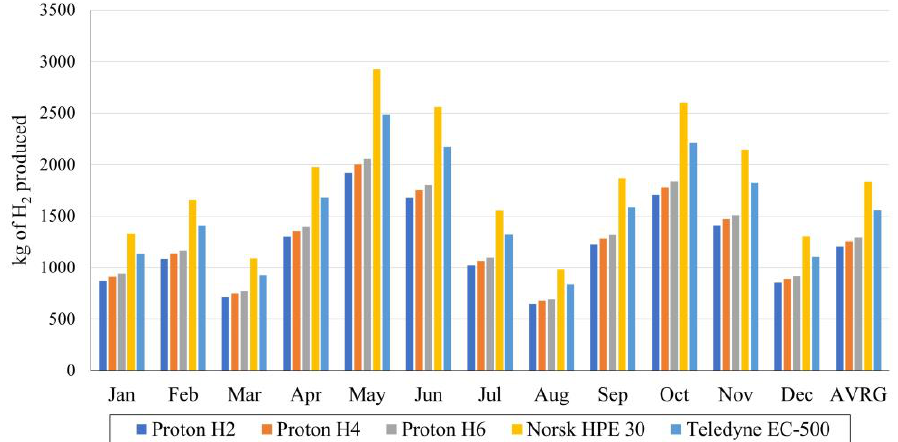
Figure 7. Monthly and average H 2 production from all analyzed electrolyzers.